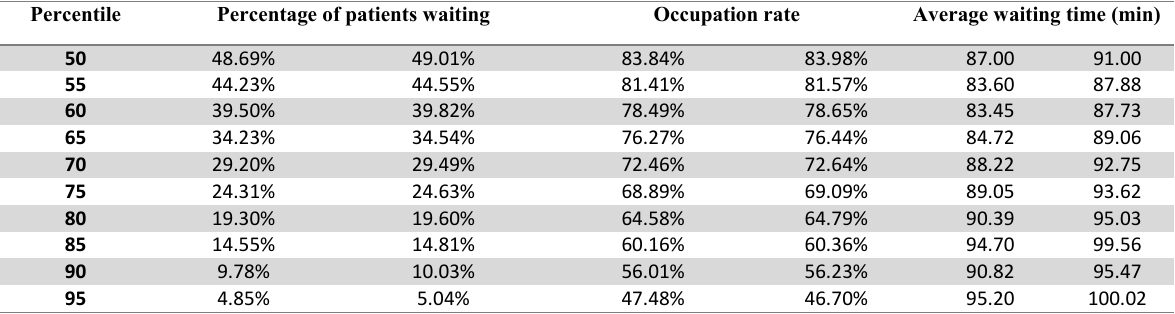
Confidence intervals (95%) for the indicators Percentile Percentage of patients